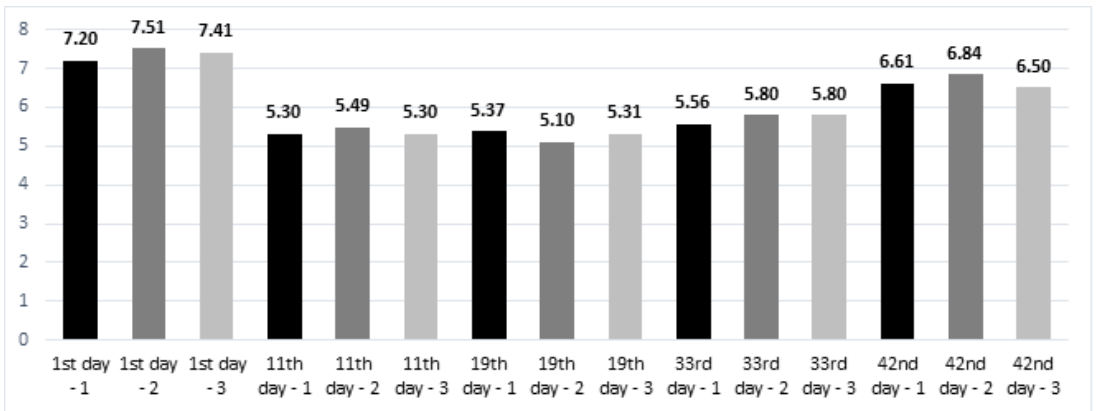
Figure 1. pH of the litter. Notes: 1—control group; 2—group with halloysite in the litter; 3—group with zeolite in the litter; 1st day—stater feed period; 11th day—grower 1 feed period; 19th day—grower 2 feed period; 33rd day—finisher feed period; 42nd day—slaughter day; sampling was performed once on the mentioned days. No significant differences between groups were found ( p > 0.05); mean values from various days were significantly different, with p -value < 0.05.